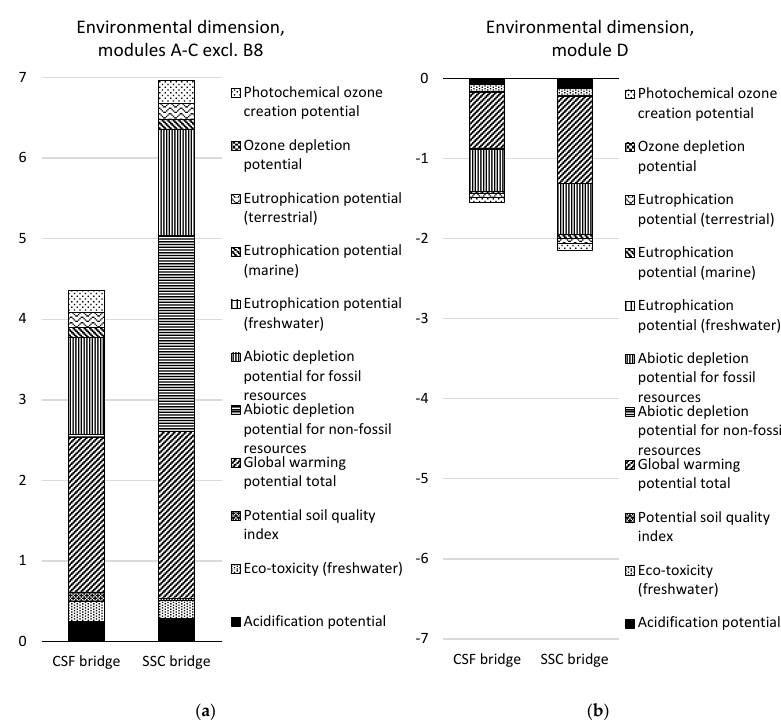
Figure 7. Comparison of the design concepts in the environmental dimension for ( a ) life cycle stages A–C excluding module B8 and ( b ) module D per indicator and for the functional unit. Note that the ozone depletion potential indicator bar cannot be seen in the figure since it is very small.